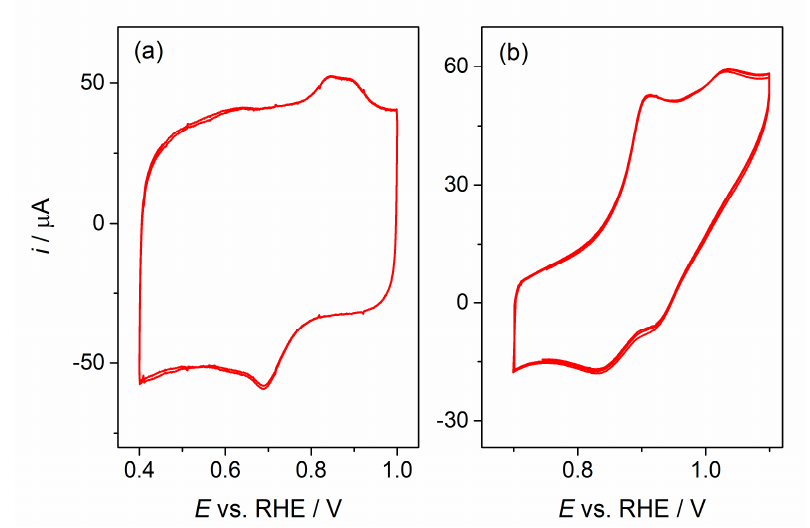
Figure 1. Cyclic voltammograms of glassy carbon (GC)/C-CuL ( a ) and GC/C-L ( b ) electrodes in 0.1 M NaOH solution saturated with N 2 (1 atm). Scan rate: 0.05 V s − 1